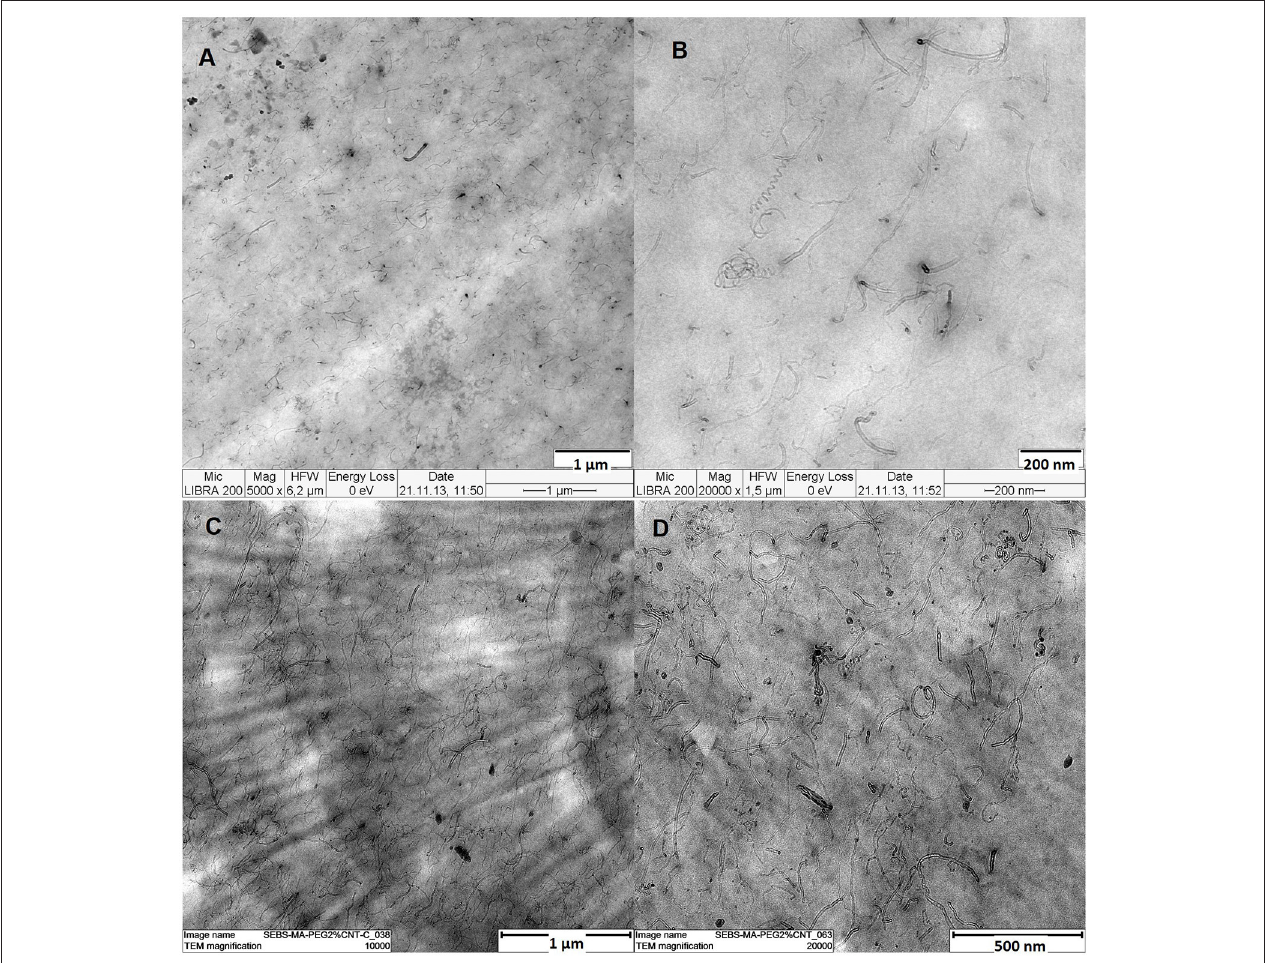
FIGURE 3 | TEM images of (A,B) SEBS-MA/2MWCNT-P and (C,D) SEBS-MA-PEG/2MWCNT-P.